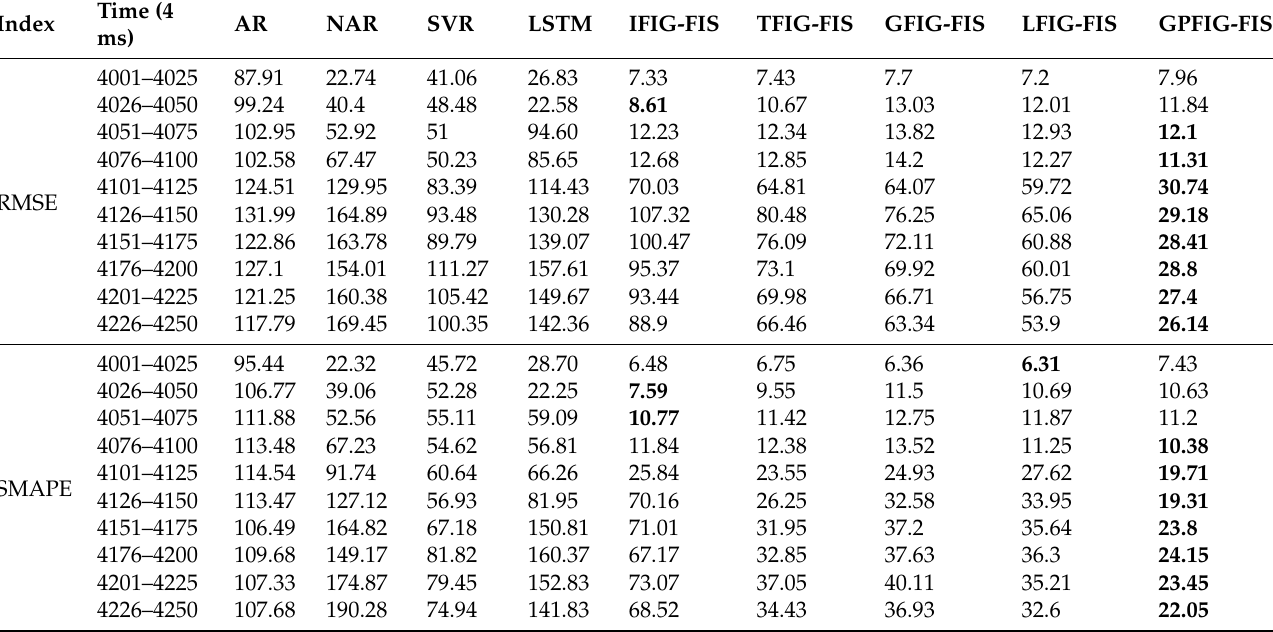
Table 3. Comparison of the prediction indexes of ECG time series.